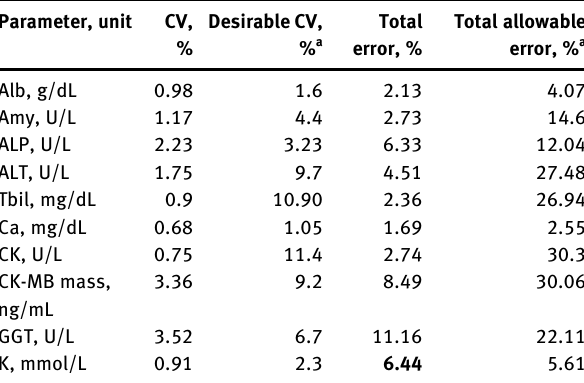
Bold number indicates total error exceeding the total allowable error.